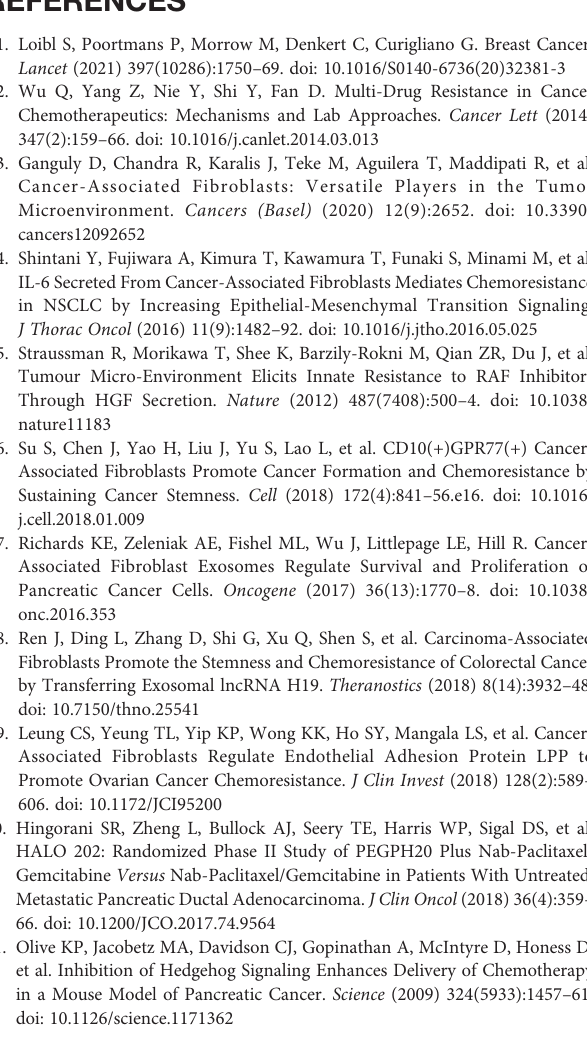
treatment and rCTGF treatment for 48 hrs. (B) CCK8 showed the IC50 of paclitaxel on MDA-MB-231 and HS578T cells cultured alone ( – ) or co-cultured with fi broblasts with or without ATL-1 treatment for 48 hrs. (C) Trypan blue exclusion assay showed the live cell counts after paclitaxel treatment on MDA-MB-231 and HS578T cells cultured alone( – ) or co-cultured with fi broblasts with or without 50 m M ATL-1 treatment for 48 hrs. ATL-1 increased the growth-inhibiting effects of paclitaxel in co-culture systems (NC), which was attenuated by the overexpression of CTGF in fi broblasts (CTGF-OE). (A – C) Three technical replicates were performed for each of the three biological replicates. Mean ± SD, * p < 0.05, ** p < 0.01, *** p